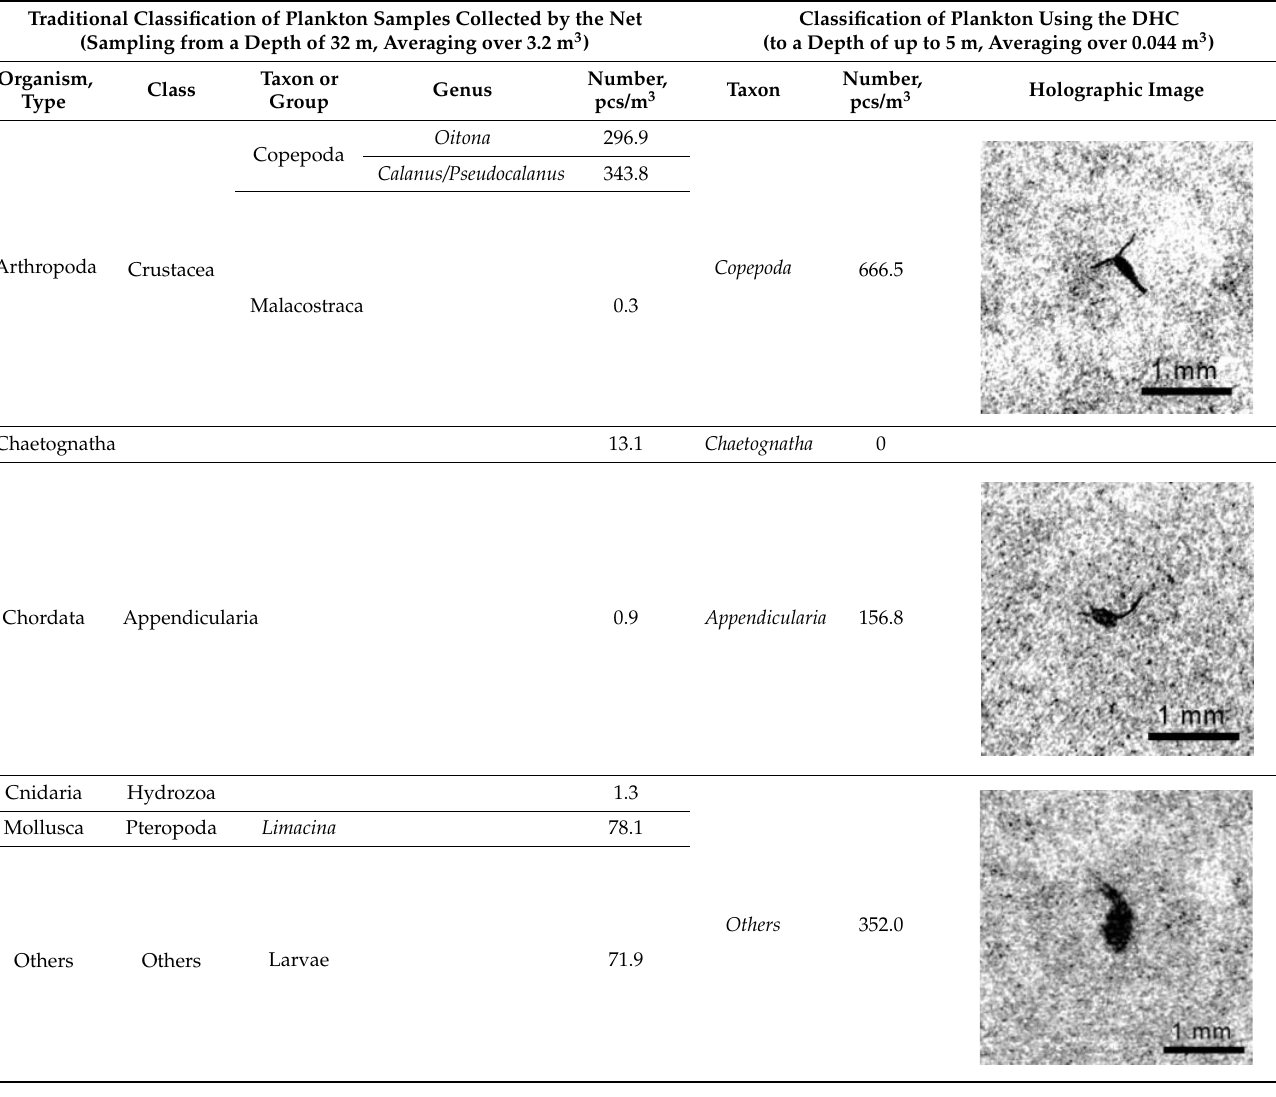
Table 6. Data for comparison of plankton measurements at station No. 6961.